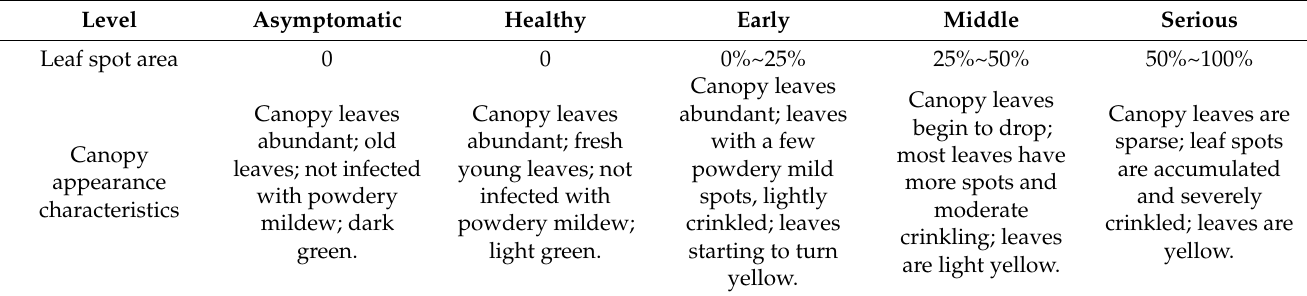
Figure 3. Examples of powdery mildew development at different infection periods. Table 1. Different stages of powdery mildew infection in rubber tree